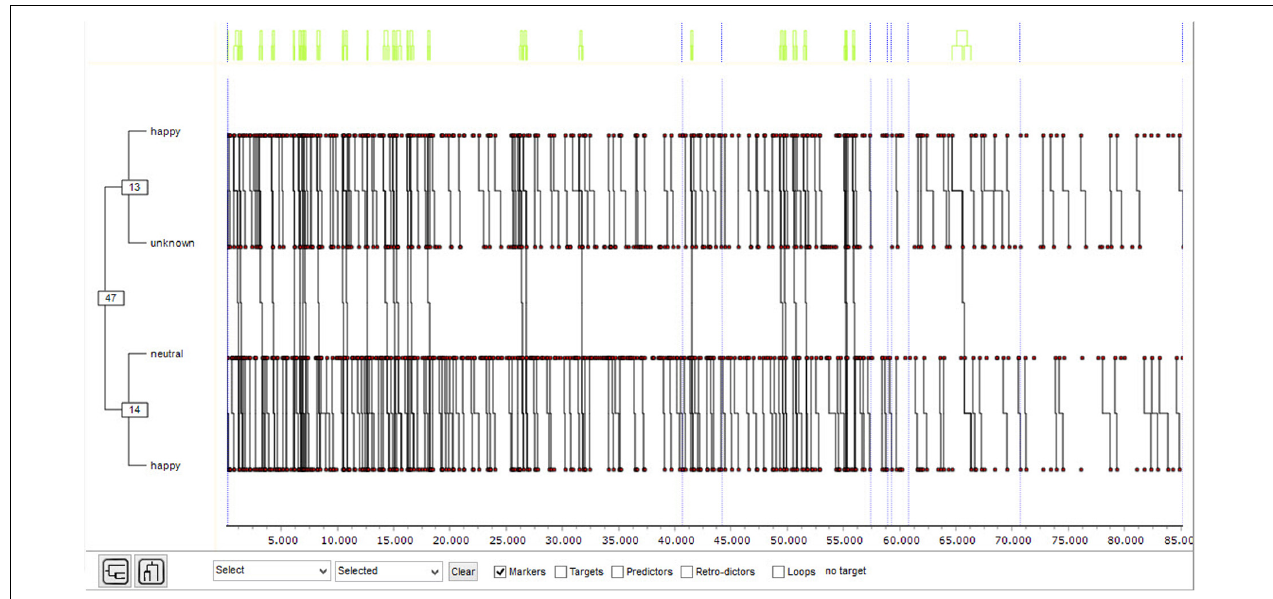
FIGURE 2 | T-pattern 1 for boys (significance level = 0.005; minimum number of occurrences = 30).